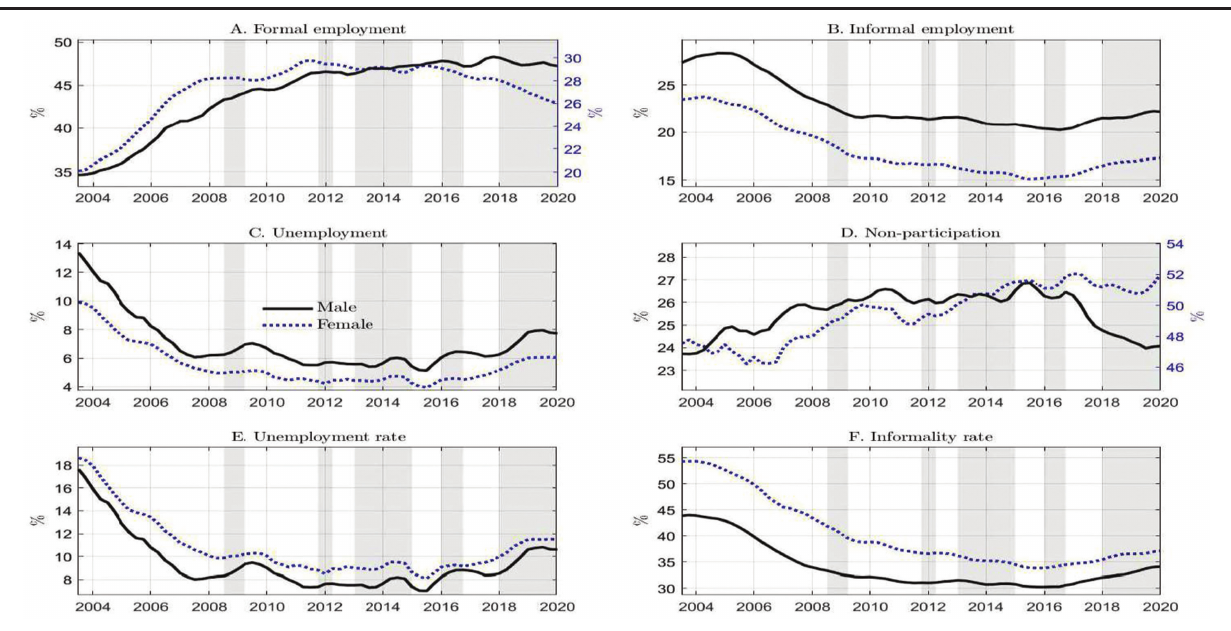
Stocks: Male versus female.